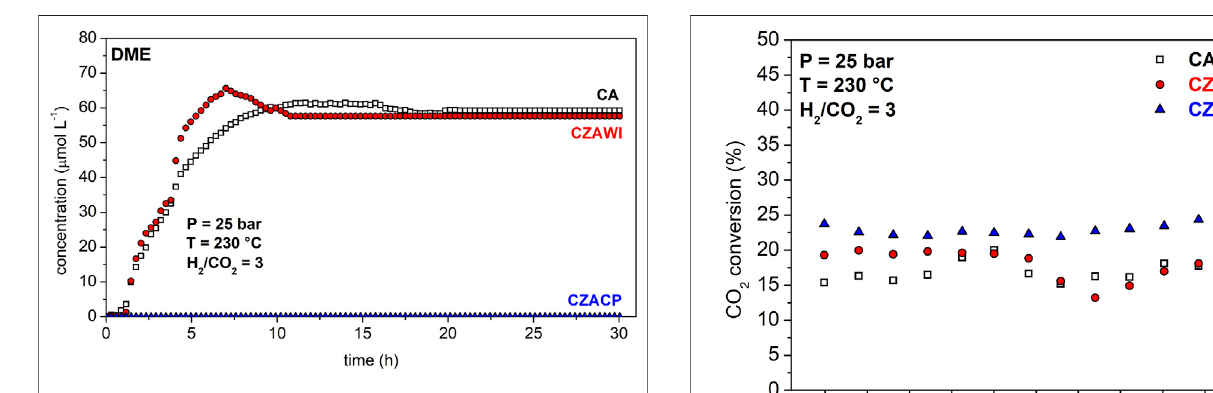
FIGURE 8 | DME concentration at the end of the reactor using CA, CZAWI, and CZACP.